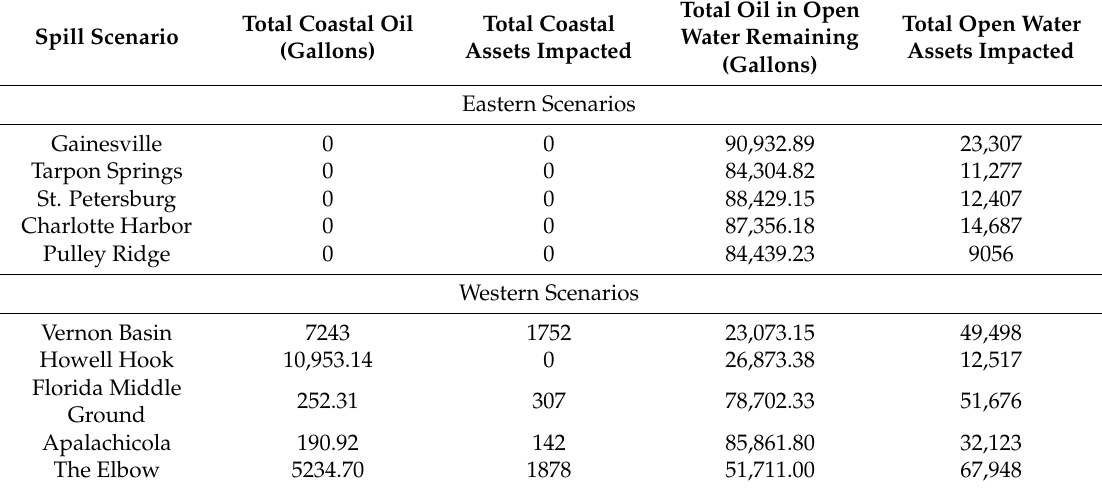
Table 2. Total oil and number of assets impacted from each of the spill scenarios and the total amount of oil not beached following 60 days of simulation. Values denoted here are used in the calculation of total scaled